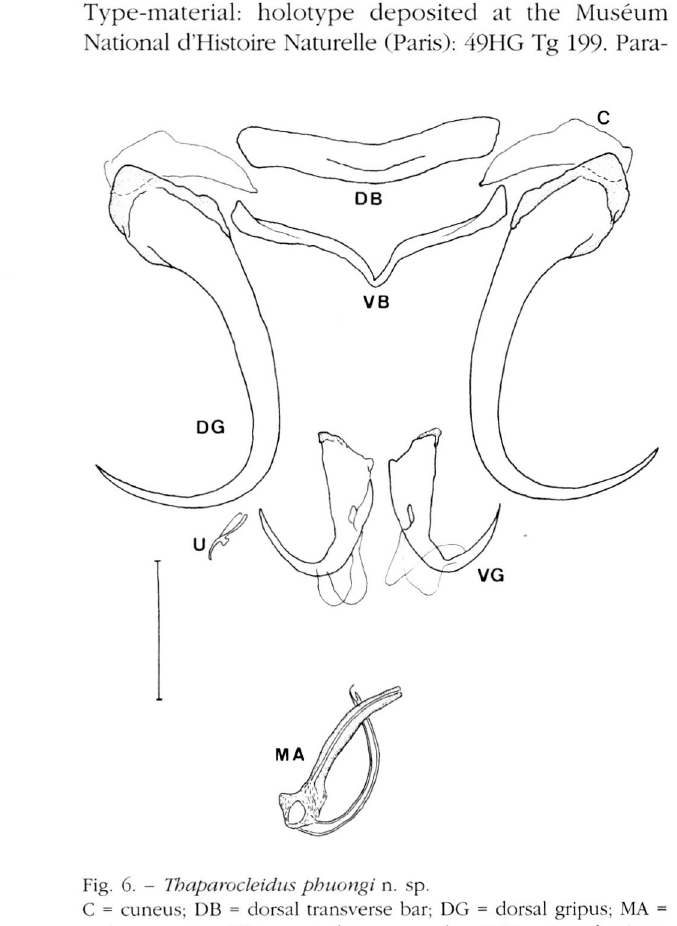
Fig. 6. - Thaparocleidusphuongi n. sp. C = cuneus; DB = dorsal transverse bar; DG = dorsal gripus; MA = male apparatus; VB = ventral transverse bar; VG = ventral gripus; I' = uncinuli. Bar = 30